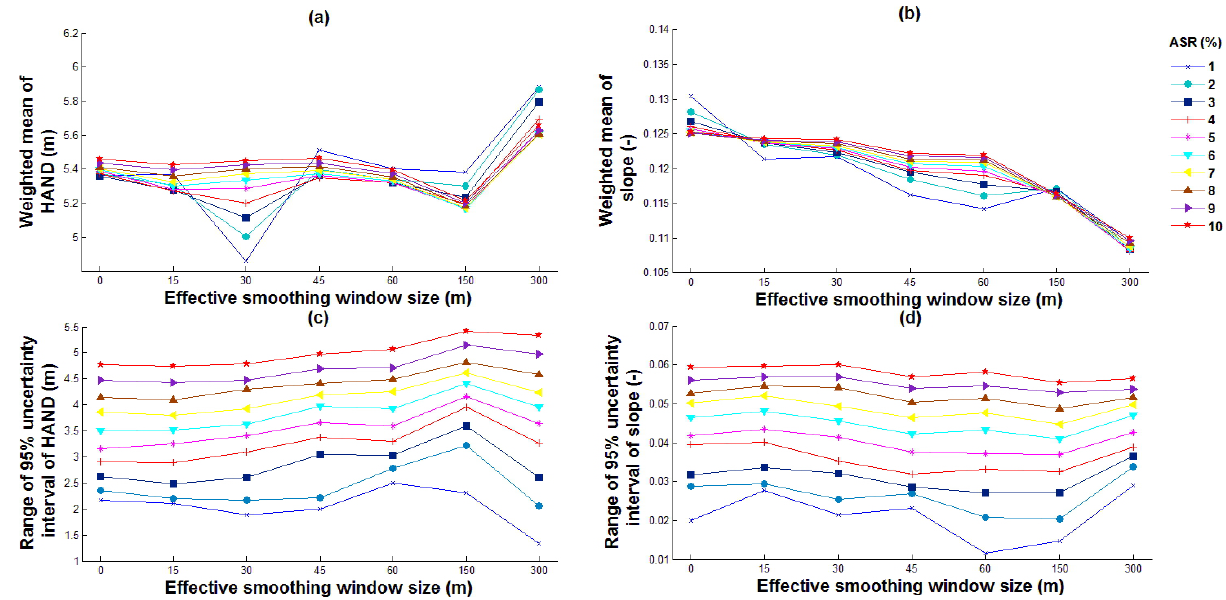
Fig. 6. (a) Likelihood weighted mean values of HAND for the modeling results retained as behavioral vs. different effective smoothing window sizes for acceptable sample rate (ASR) of 1–10%; (b) likelihood weighted mean values of slope for the modeling results retained as behavioral vs. different effective smoothing window sizes for acceptable sample rate (ASR) of 1–10%; (c) parameter range for 95% (2.5– 97.5%) uncertainty interval of HAND (d) parameter range for 95% (2.5–97.5%) uncertainty interval for slope. Note that for comparative reasons and due to the inherent subjectivity in the choice of a threshold for defining behavioral parameter sets, the sensitivity of the parameter uncertainty ranges to varying thresholds here is illustrated by showing the parameter ranges for best 1–10% of the acceptable sample rate